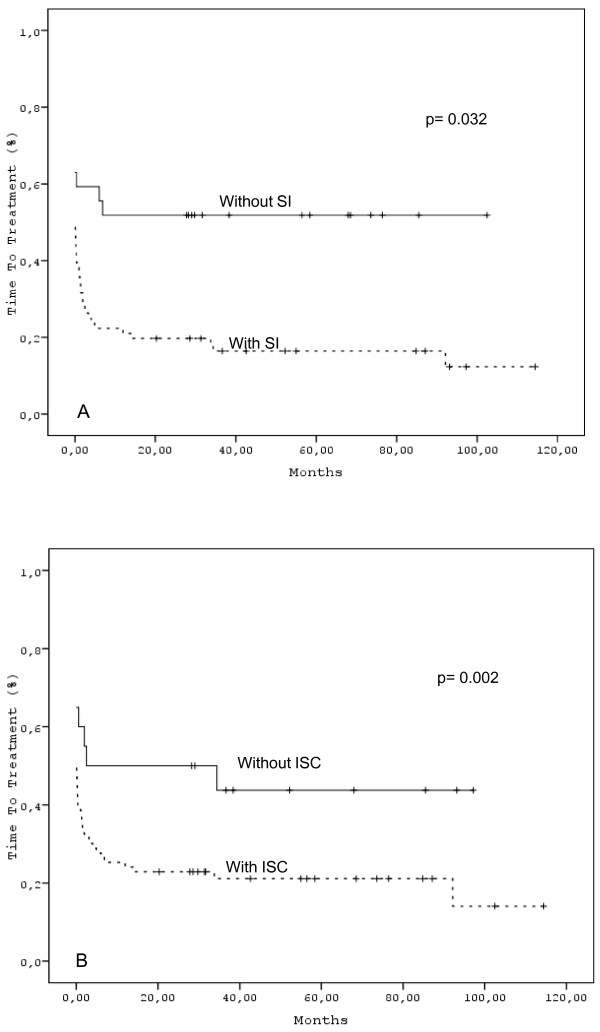
Time to treatment according (A) to the presence or absence of ISC and (B) SI.